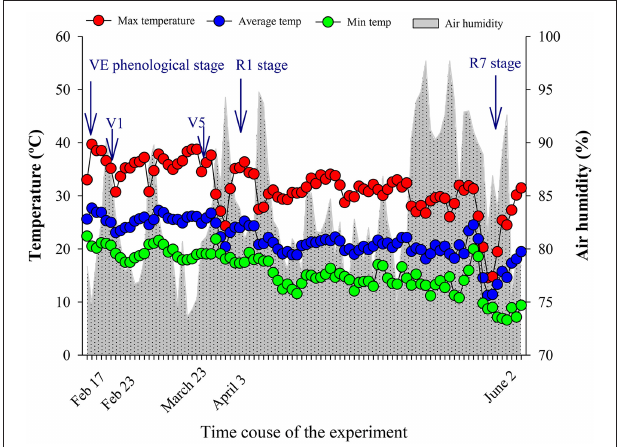
FIGURE 1 | Maximum, average, minimum temperature ( ◦ C), and air humidity (%) data during the experimental period. Vegetative and reproductive phenological stages (VE, emergence—cotyledons above the soil surface; V1, first node—fully developed leaves at unifoliolate nodes, and V5, fifth nodule—five nodes on the main stem with fully developed leaves beginning with the unifoliolate nodes; R1, beginning bloom—one open flower at any node on the main stem and R7, beginning maturity—One normal pod on the main stem that has reached its mature pod color; Fehr et al., 1971).